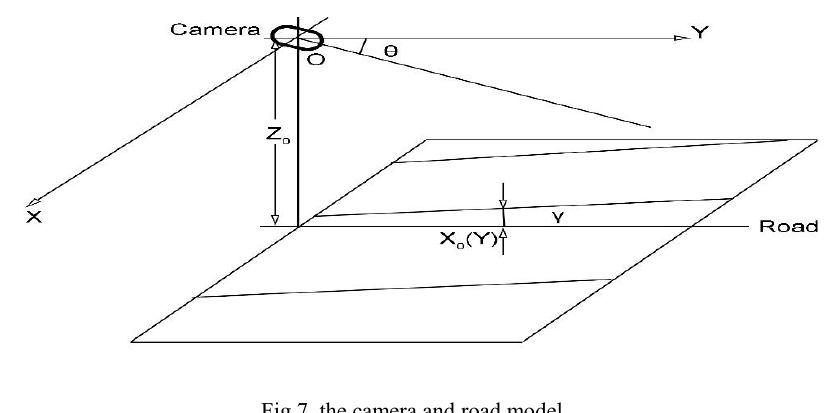
Fig 7. the camera and road